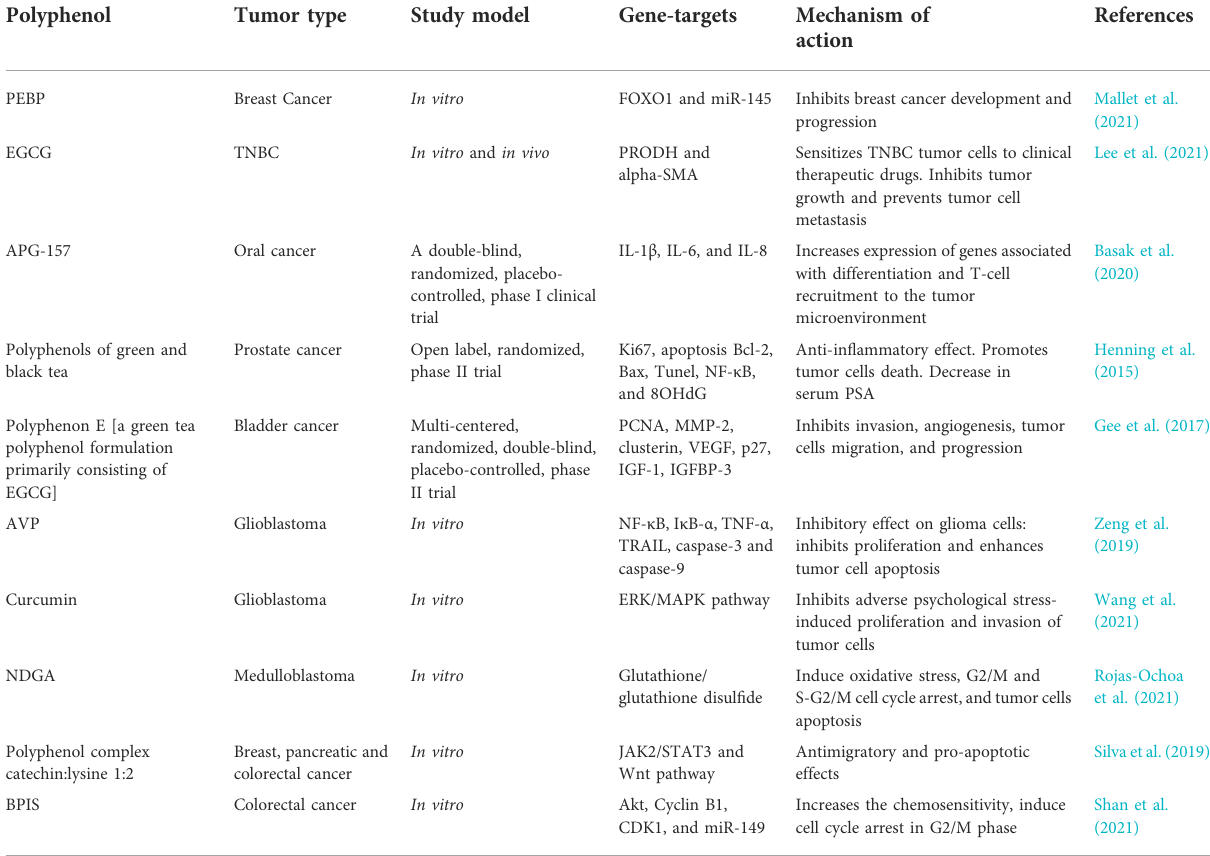
TABLE 1 Results of some preclinical and clinical experiments on the study of the therapeutic effect of polyphenols in tumors. Polyphenol